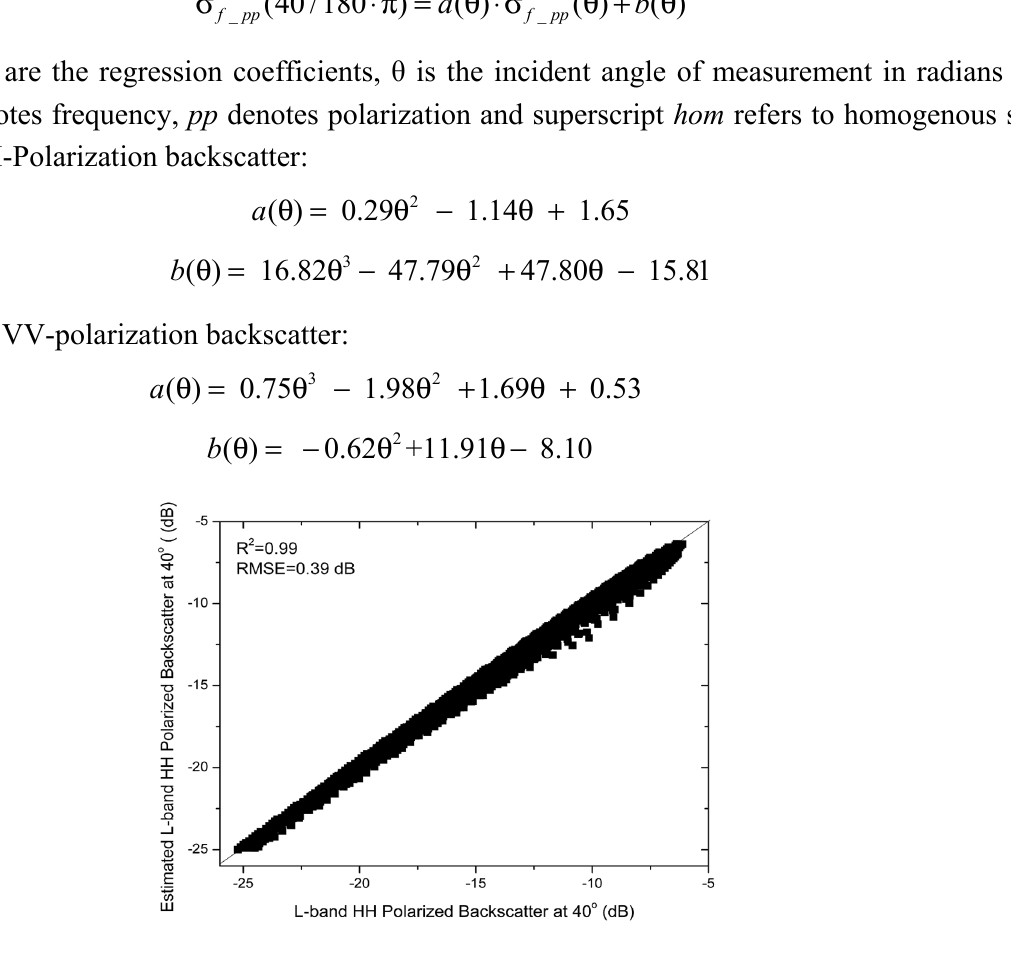
Figure 8. Angular relationship between L-band HH polarized backscatter at 50° and 40° based on the AIEM